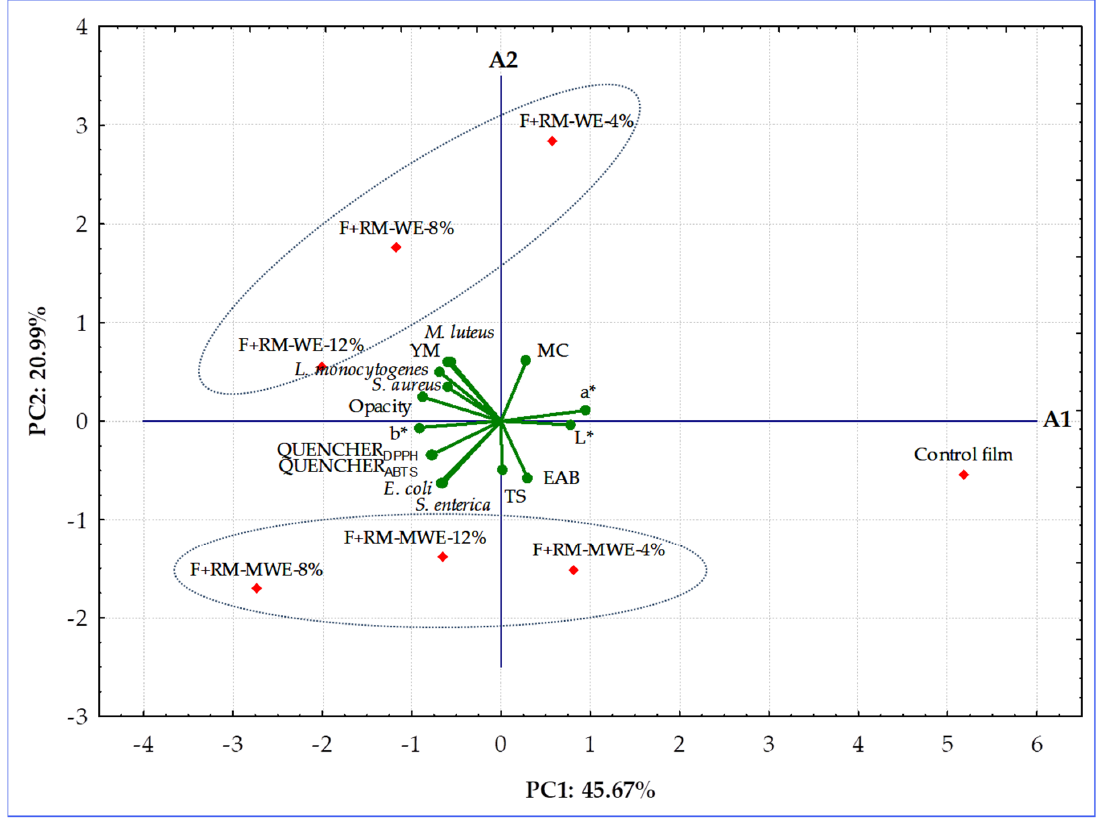
Figure 6. Biplot of scores and loadings of data obtained from mechanical, optical, radical scavenging, and antibacterial properties of the prepared gelatin-based films. Blue circles indicate the distribution of variables in two groups based on the activity of the gelatin films with RM-WE against Gram-positive bacteria and films with RM-MWE against Gram- negative